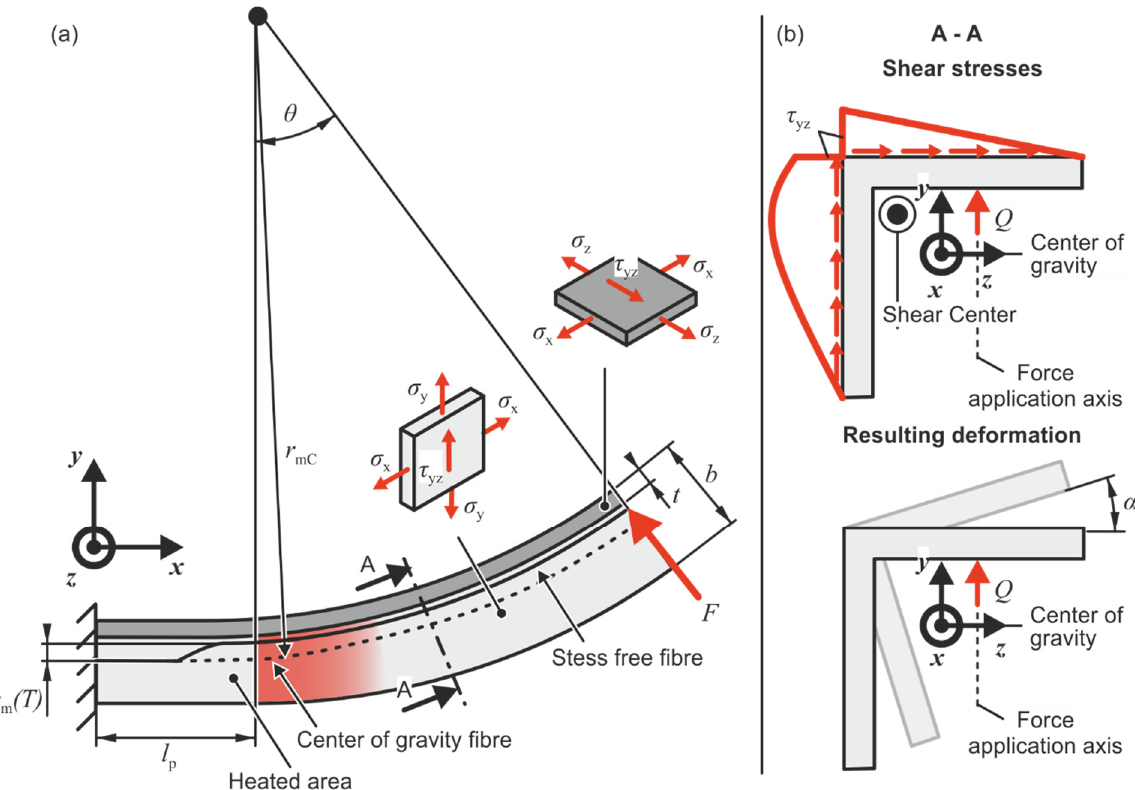
Figure 6. Mechanical model for analytical calculation. ( a ) length direction, ( b ) corresponding cross-sectional cut A-A.